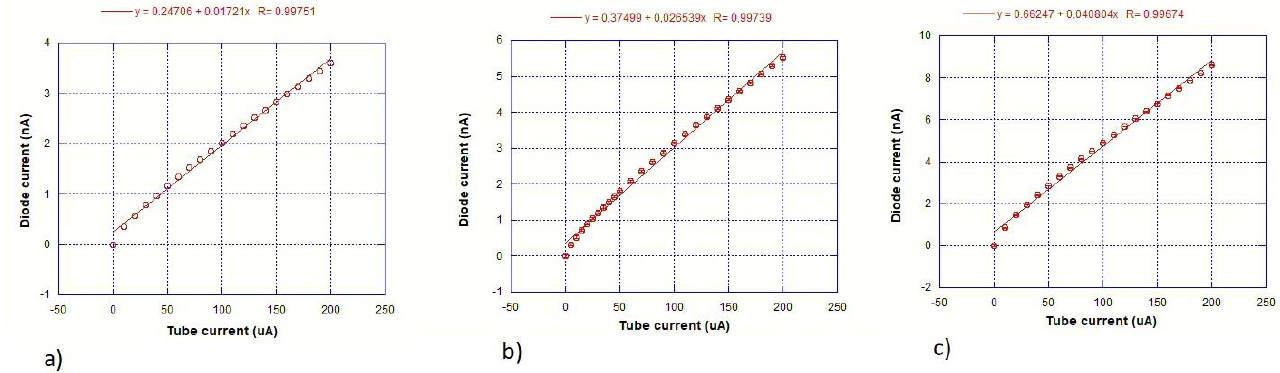
Figure 11. ( a ) Diode current versus X-ray tube current with diode biased at 25 V, ( b ) diode current versus X-ray tube current with diode biased at 50 V, ( c ) diode current versus X-ray tube current with diode biased at 100 V. The measurement were taken using a Keithley 2410C.